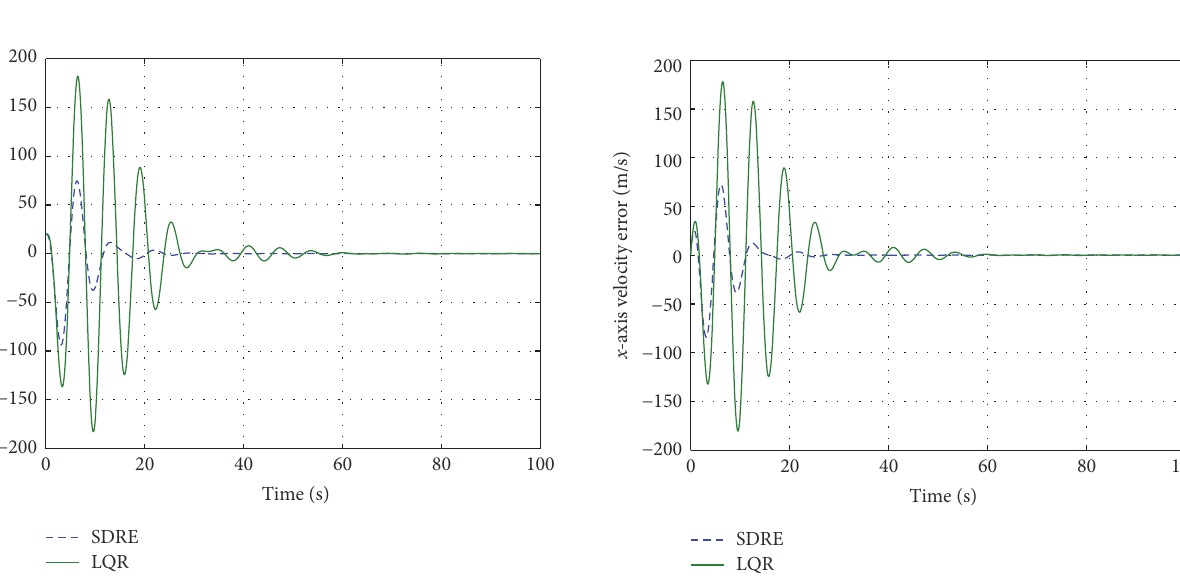
Figure 8: 𝑍 axis position error variation curve.